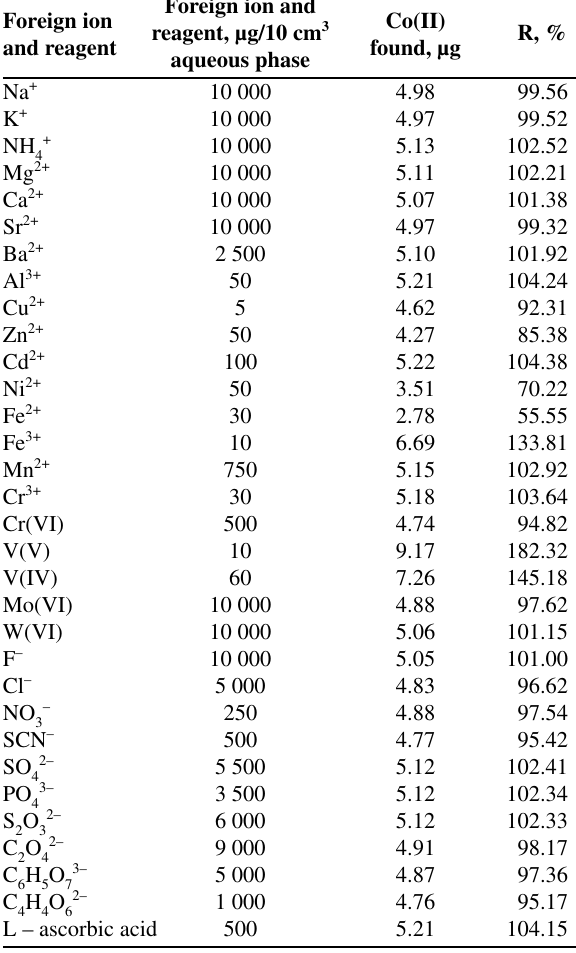
Table 3. Effect of foreign ions and reagents on the complex forma- tion of the ion-associate Co(II)–TAR–INT for extraction in the pre-